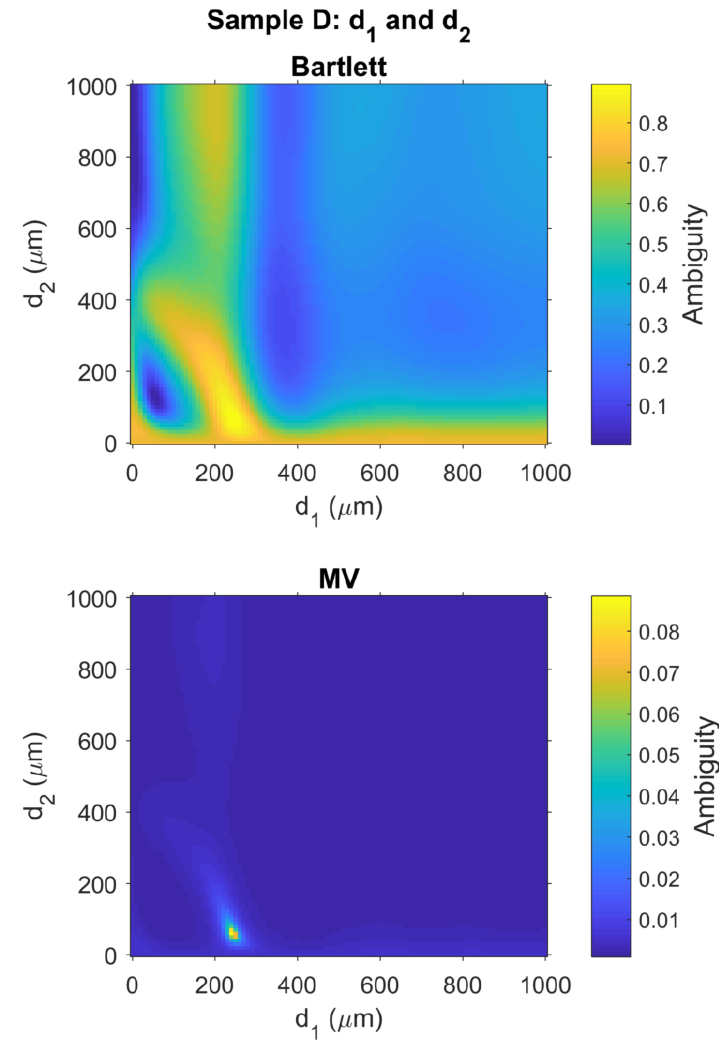
Figure 6. Matched field ambiguity surfaces provide estimates for the thickness of the polycarbonate layer, d 1 , and the air gap, d 2 , as illustrated in Figure 1 with layer thickness for Sample D given in Table 1. ( Top ) Bartlett processor has a global maximum d 1 = 250 µ m and d 2 = 60 µ m; ( Bottom ) MV processor has a global maximum d 1 = 240 µ m and d 2 = 60 µ m. These results are consistent with ground truth measurements with a Vernier caliper. See Table 2 for a comparison of measurement errors for layers in all